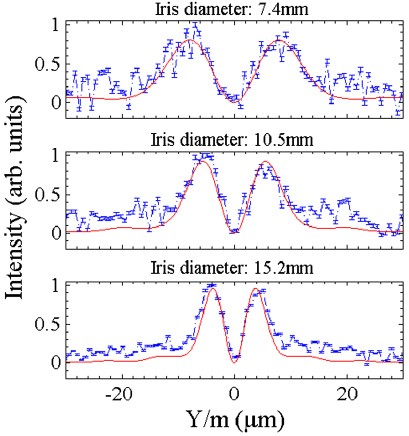
FIG. 15. OTR PSFs measured for different iris diameters ( γ ¼ 2500 ; λ ¼ 550